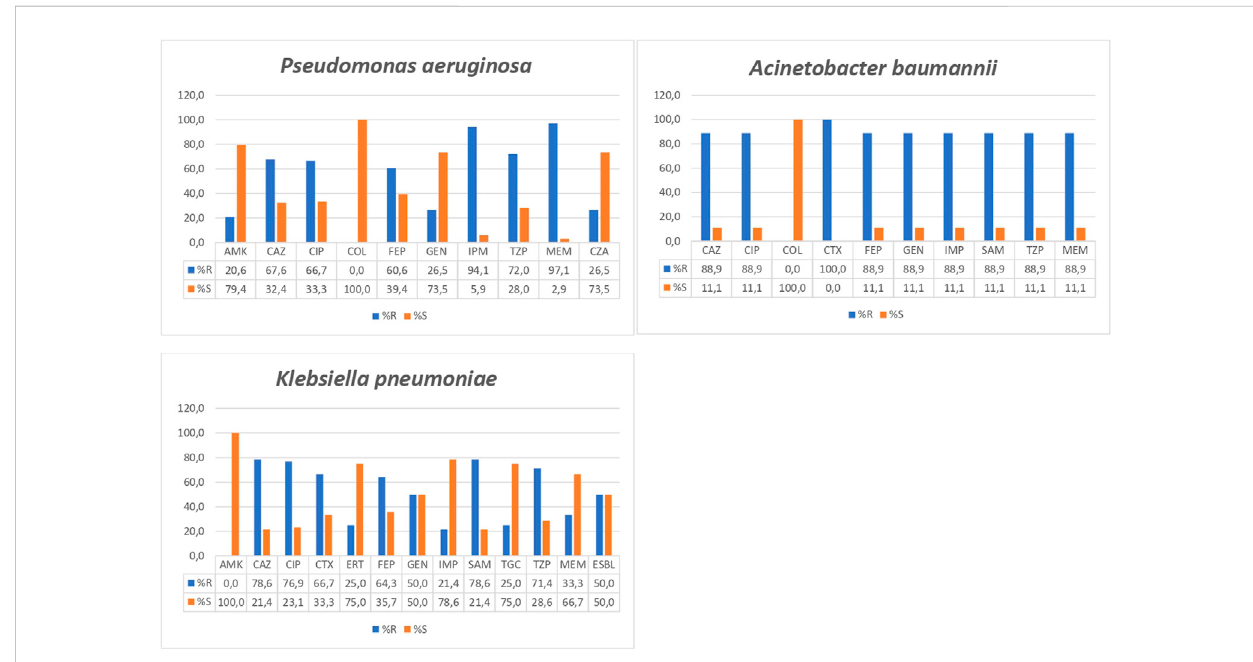
Antimicrobial resistance levels in Pseudomonas aeruginosa , Acinetobacter baumannii , and Klebsiella pneumoniae. CTX, cefotaxime; CAZ, ceftazidime;FEP,cefepime;SAM,ampicillinplussulbactam;TZP,piperacillinplustazobactam;IMP,imipenem;MEM,meropenem;ERT,ertapenem;GEN, gentamicin; AMK, amikacin; CIP, cipro fl oxacin; TGC, tigecycline; COL, colistin; ESBL, extended spectrum β